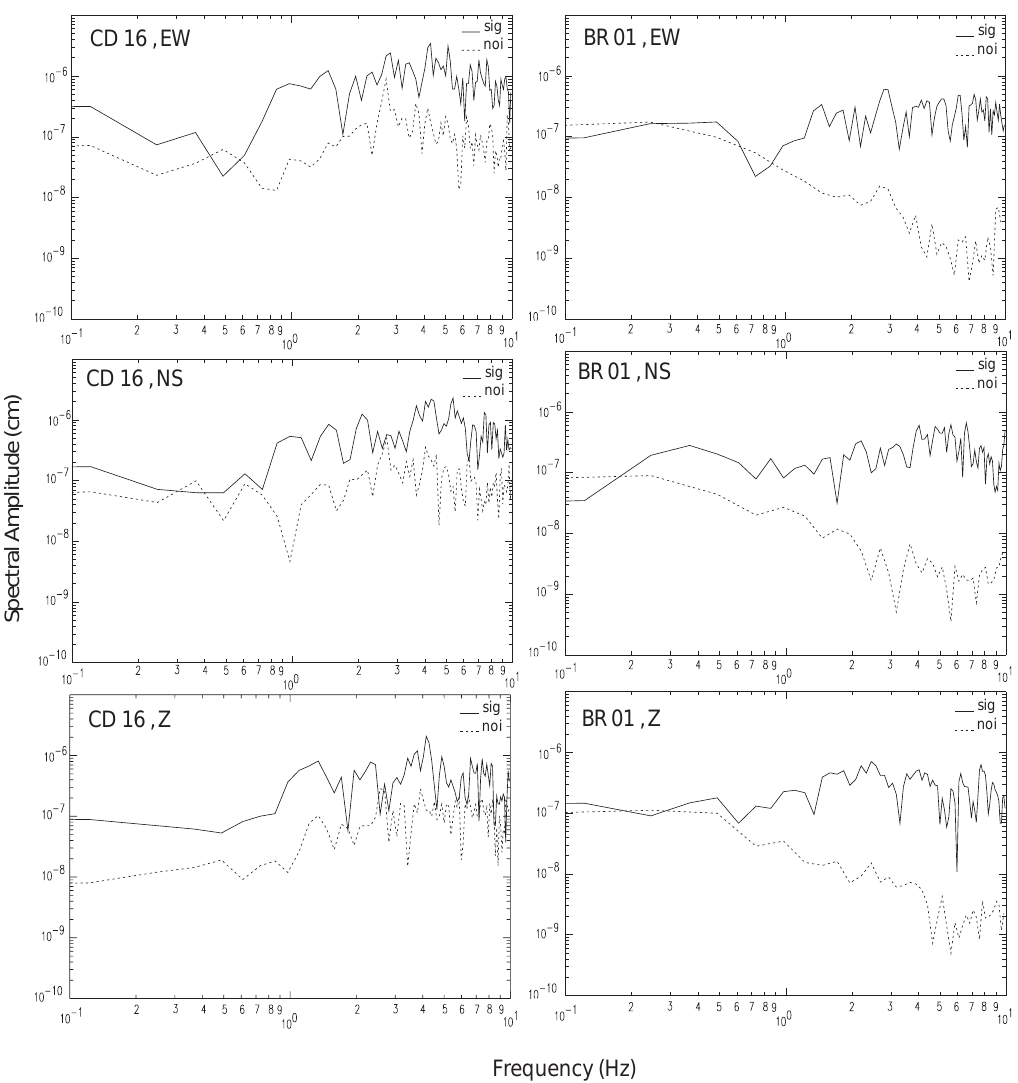
Fig. 6 . Spectra of S -wave signal and pre-event noise of the 3 components of one of the analyzed earthquake at stations BR01 and